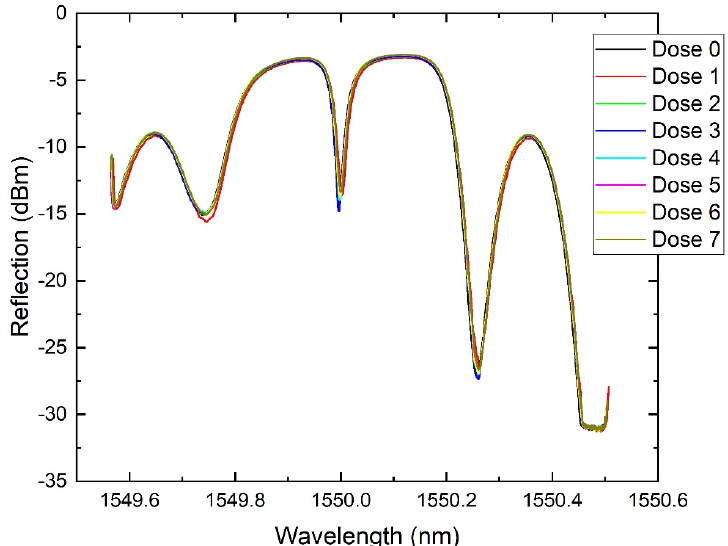
Figure 4. Collected spectra of specimen RAD03 from test Set 3 illustrating the reflection power of the FBGs vs. dose. The “characteristic FBG wavelength” denotes the central wavelength of the narrow passband feature at 1550 nm that is always present in the spectra of π –FBGs. The resolution of the Optical Gauge Amplifier (OGA) is 0.01